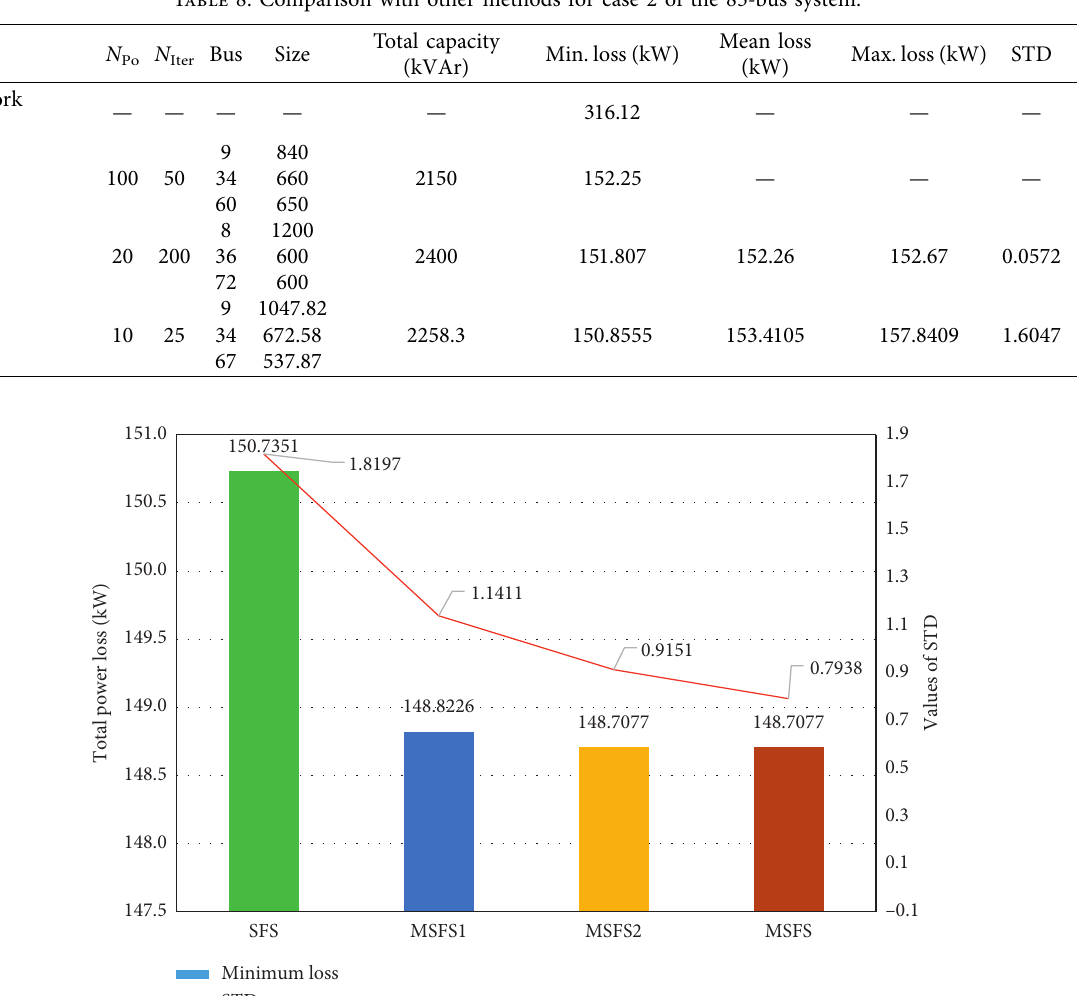
Figure 25: Minimum power loss and standard deviation of 50 trial runs obtained by SFS methods for case 3 of the 85-bus system.